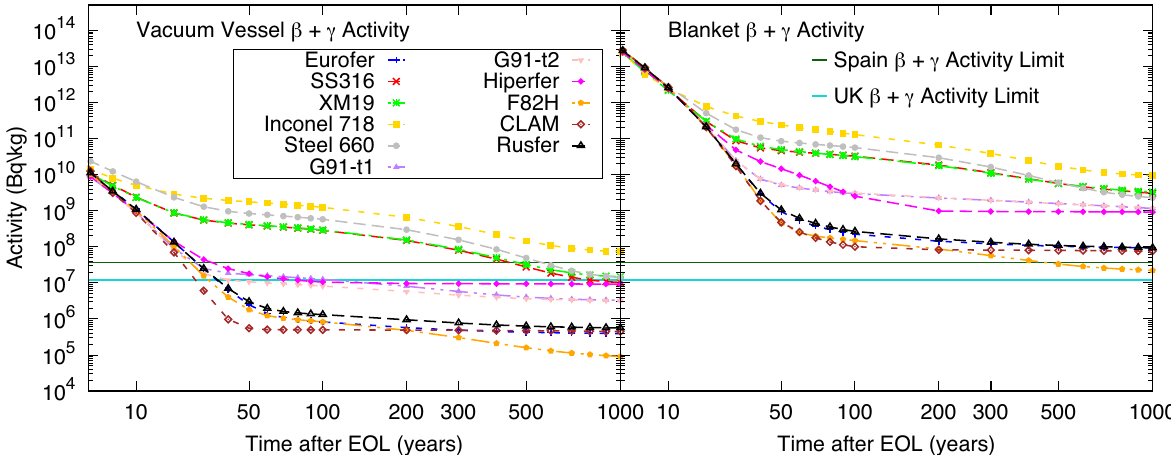
Figure 2: β + γ activities for the steels studied. The left panels show the VV results, the right the